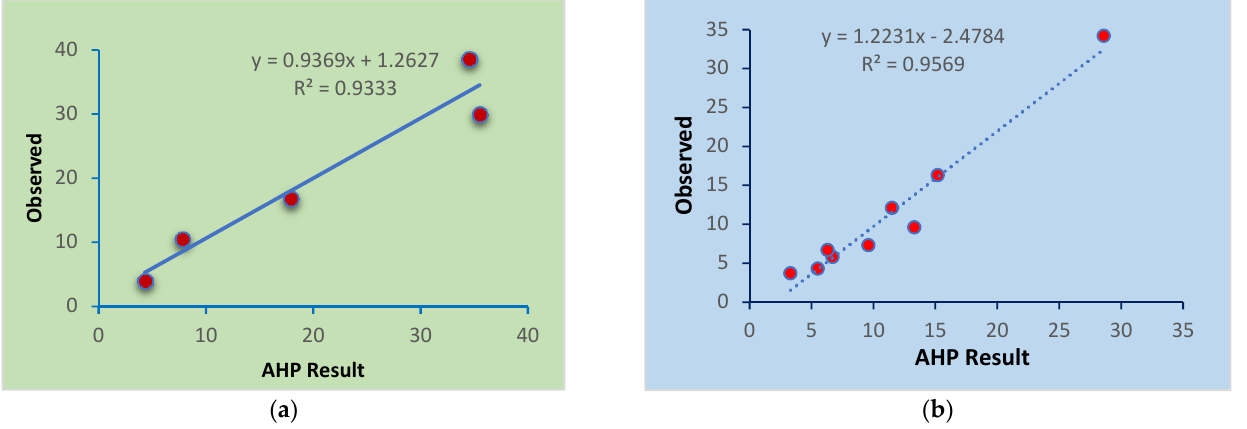
y = 0.9369x + 1.2627 R² = 0.9333